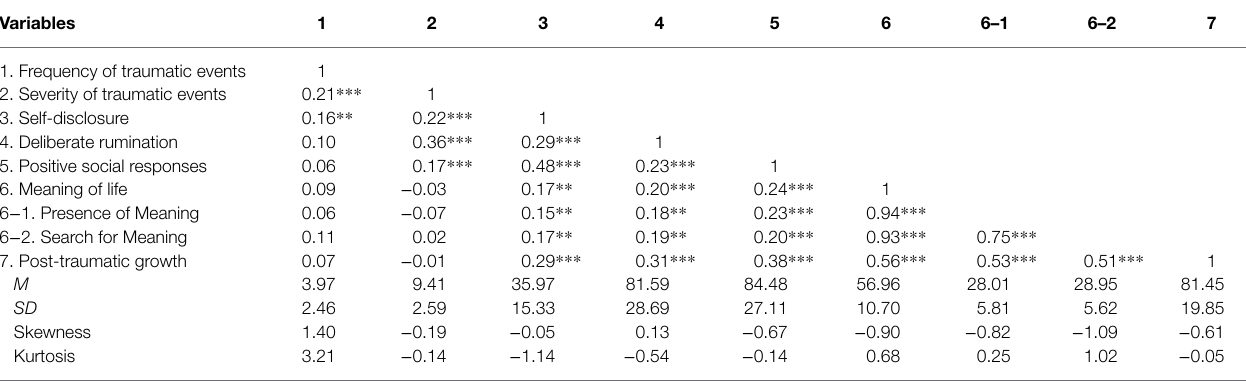
TABLE 1 | Correlational matrix of the frequency of traumatic events, severity of traumatic events, self-disclosure, deliberate rumination, positive social responses, meaning of life, and PTG ( N = 318). Variables